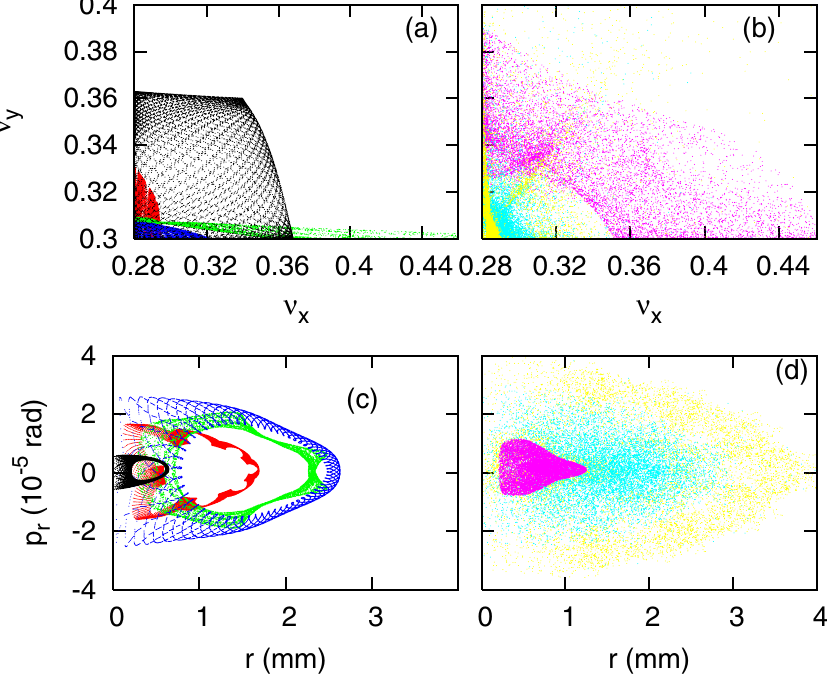
FIG. 14. (Color) Variation of horizontal and vertical tunes, and r (cid:1) p near integrable and stochastic particles, respectively. Plots (c) and (d) are the corresponding r (cid:1) p